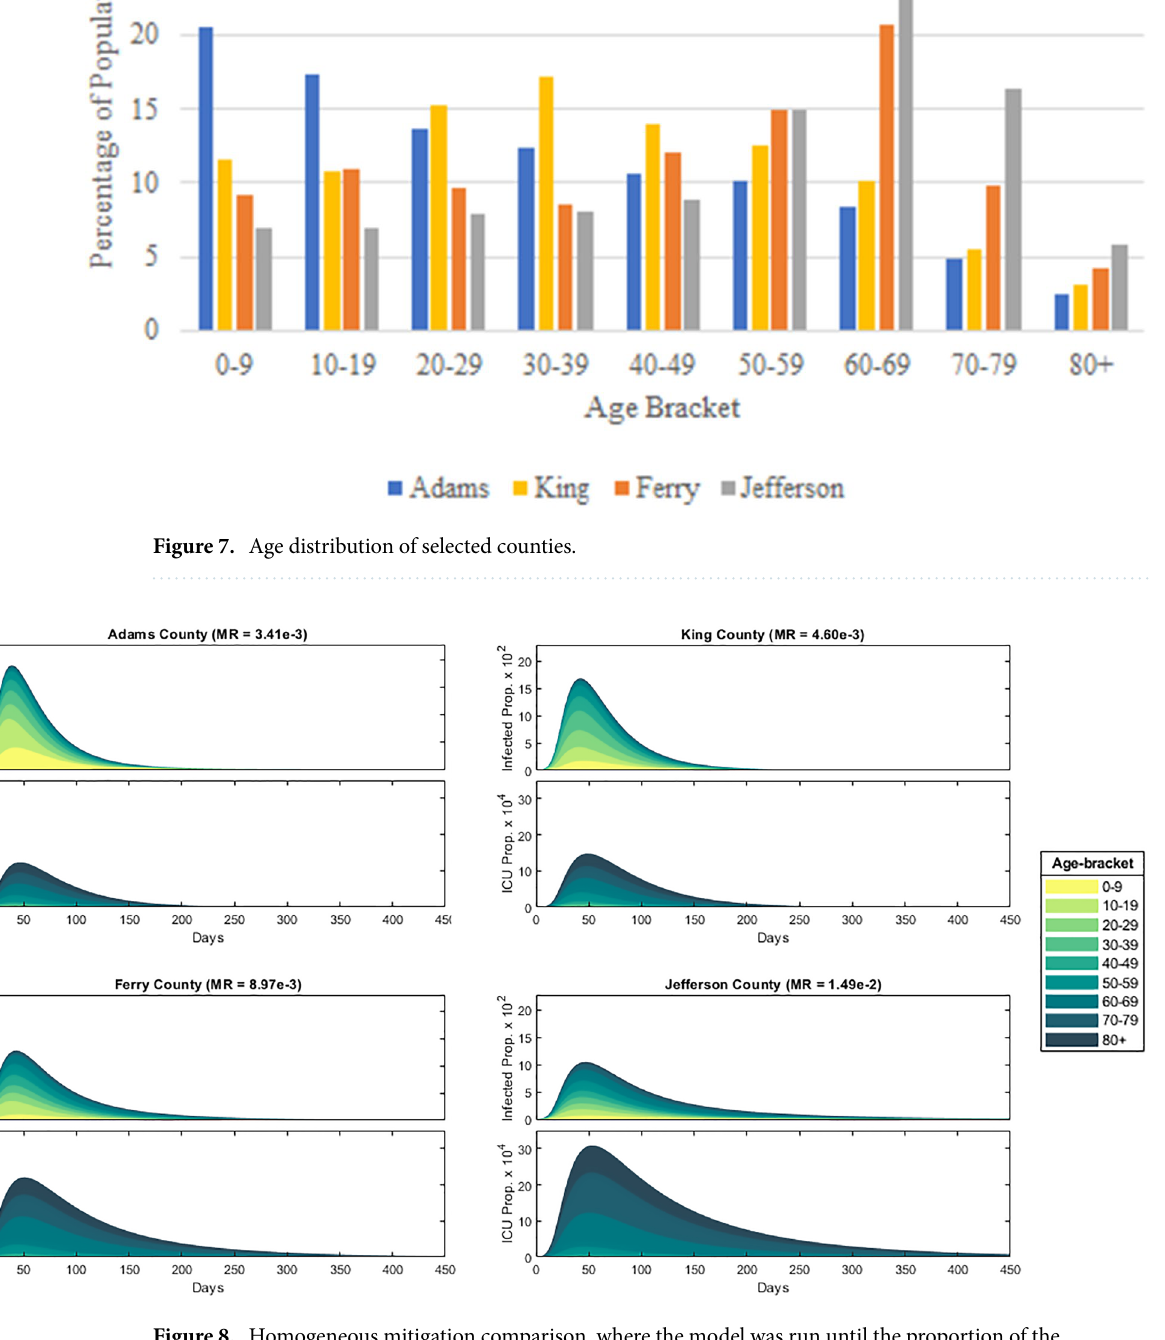
Figure 8. Homogeneous mitigation comparison, where the model was run until the proportion of the 6 population infected fell below 10 −